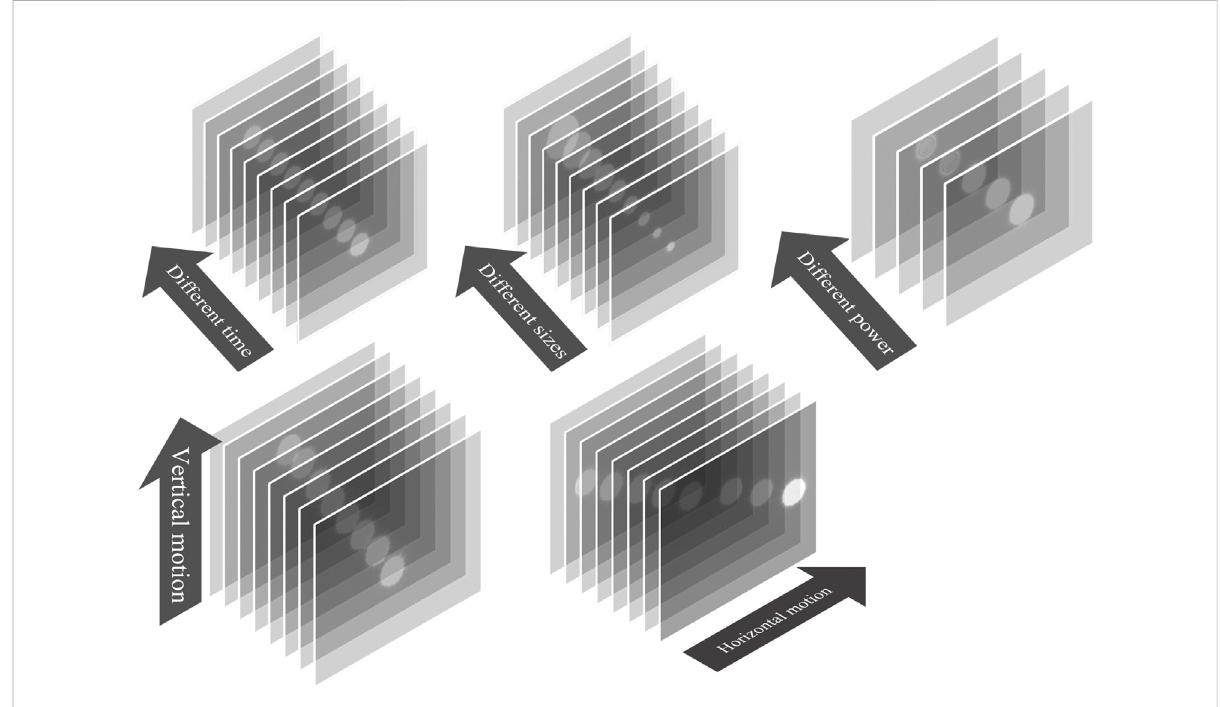
FIGURE 5 Experimental image data.